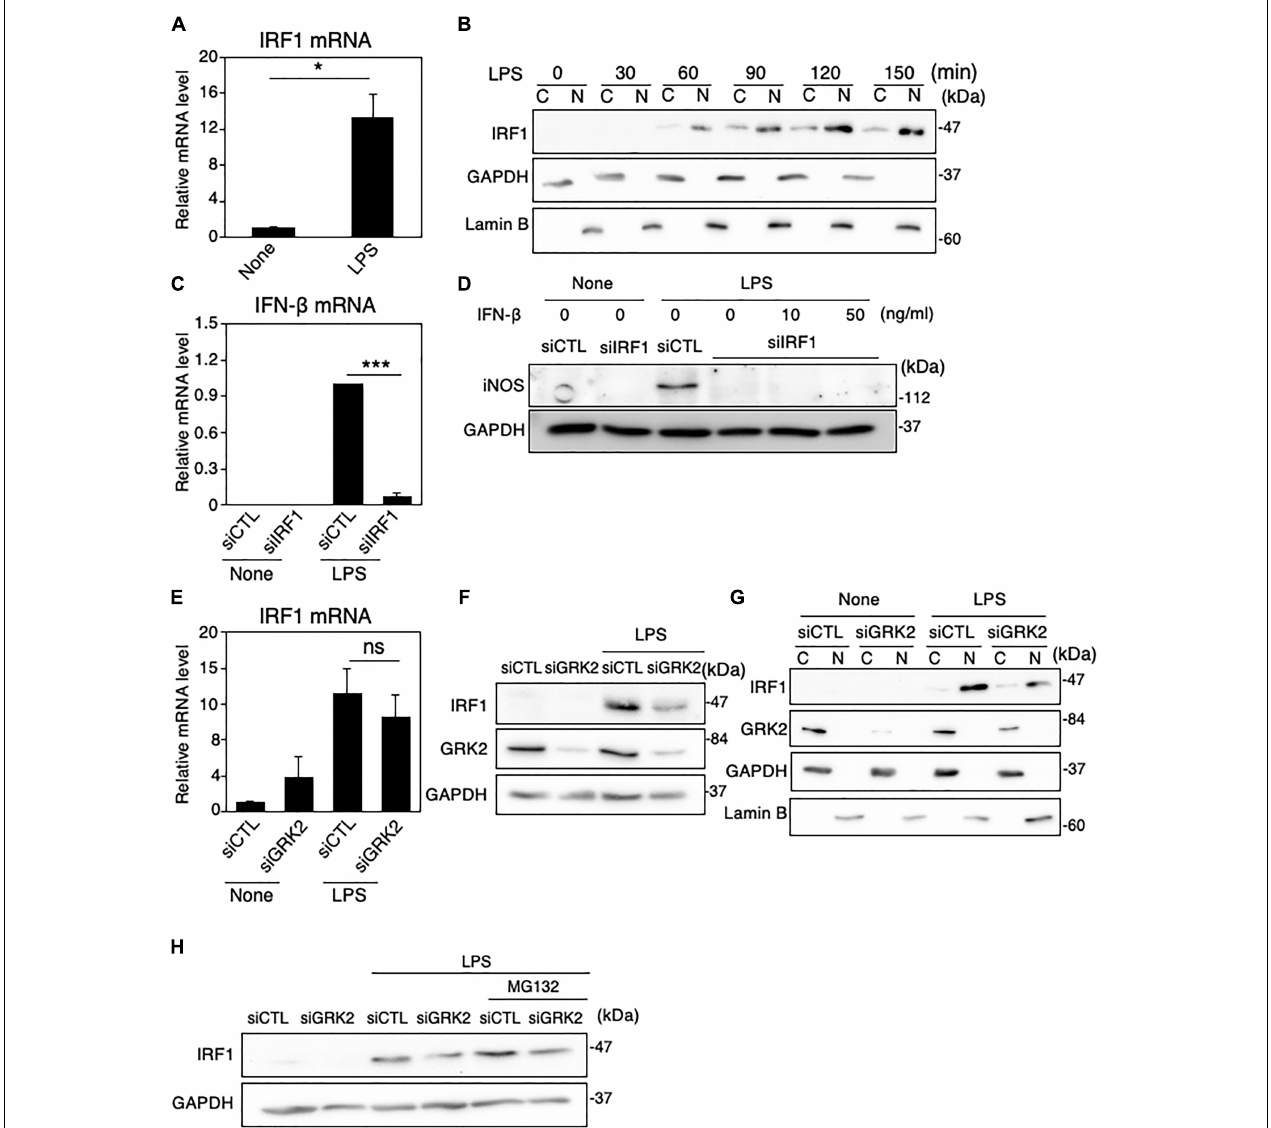
FIGURE 5 | Role of IRF1 in IFN- β -mediated iNOS expression in LPS-stimulated MG6 cells. (A) Expression of IRF1 mRNA 3 h after 100 ng/ml LPS application. (B) Cytoplasmic (C) and nuclear (N) fractions were isolated, and then the time course of changes in IRF1 levels in each fraction after 100 ng/ml LPS application was tracked by Western blot analysis. (C) Effect of IRF1 siRNAs (siIRF1) on expression of IFN- β mRNA 3 h after 100 ng/ml LPS application. (D) Effect of transfection of siIRF1 on iNOS protein expression 12 h after challenge with 100 ng/ml LPS in the presence or absence of 10 or 50 ng/ml IFN- β . (E) Effect of GRK2 siRNAs (siGRK2) on IRF1 mRNA 3 h after 100 ng/ml LPS application. The mRNA levels were expressed as a fold increase above control normalized GAPDH. (F) Effect of siGRK2 on IRF1 protein 1 h after 100 ng/ml LPS. (G) Effect of siGRK2 on IRF1 levels in C and N fractions before and 1 h after 100 ng/ml LPS was tracked by Western blot analysis. (H) Influence of MG132 on the siGRK2 effect on IRF1 protein expression 90 min after 100 ng/ml LPS. MG132 at a concentration of 2 µ M was added 30 min after LPS. All experiments were compared with those when the negative control siRNAs (siCTL) was transfected. GAPDH served as loading control and lamin B was used as a nuclear marker. Shown are representative Western blots from three independent experiments in which the same results were obtained. The bar graph results represent the mean ± SEM for three independent experiments. Ns, not significant. ∗ P < 0.05 and ∗∗∗ P < 0.001 by t -test.